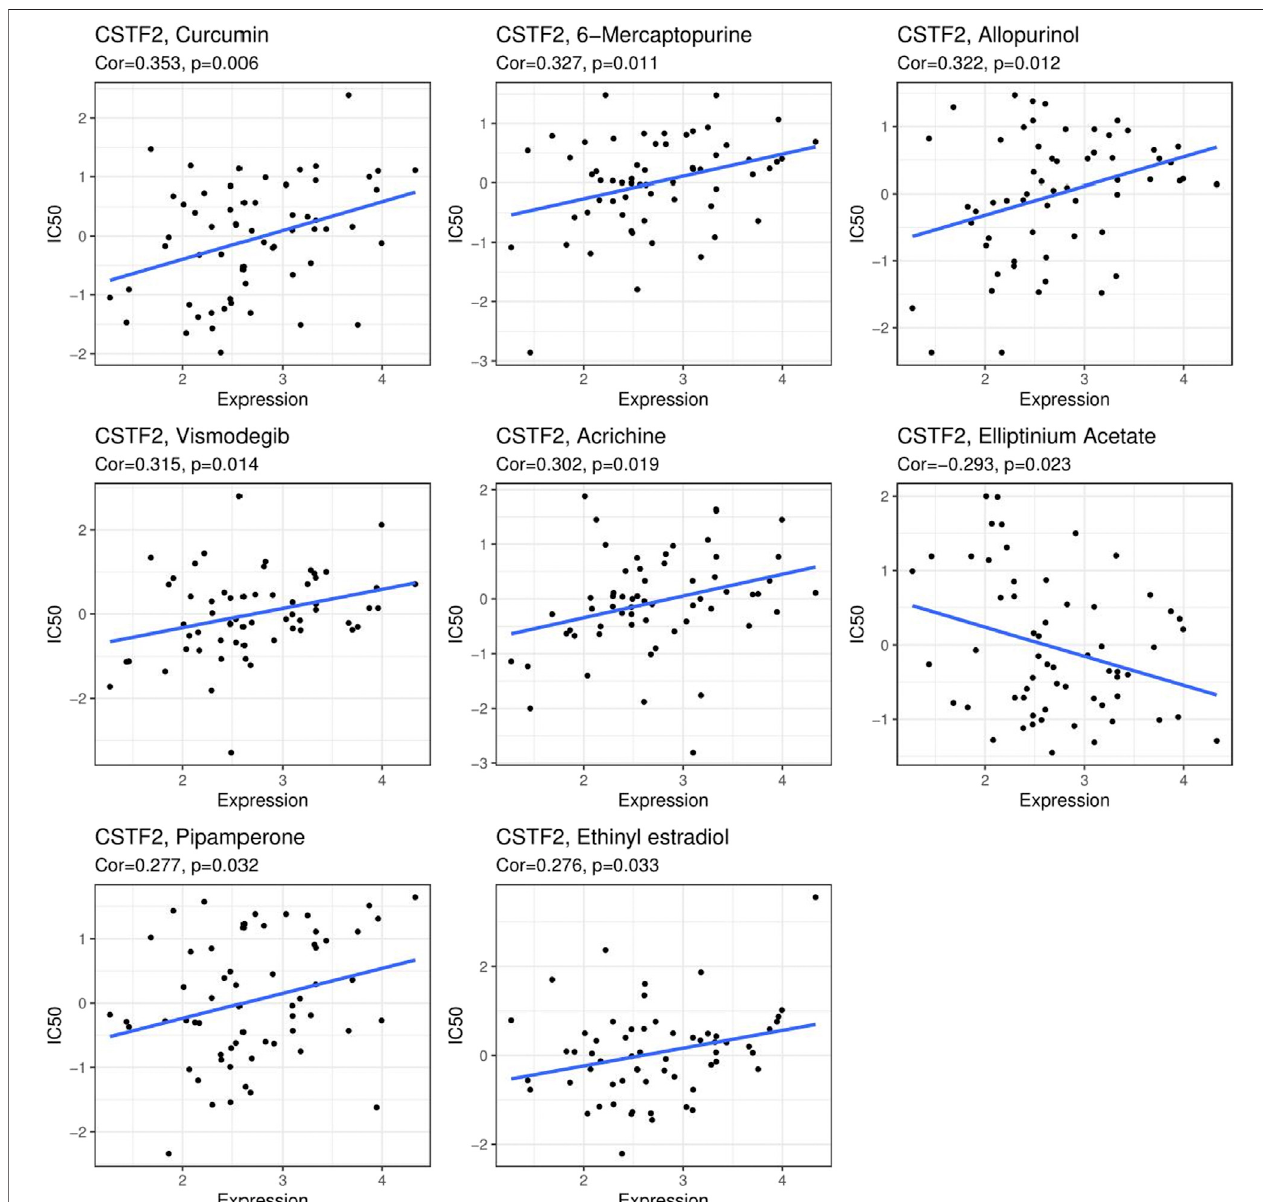
FIGURE 6 | Relationship between CSTF2 expression and common compound molecule IC 50